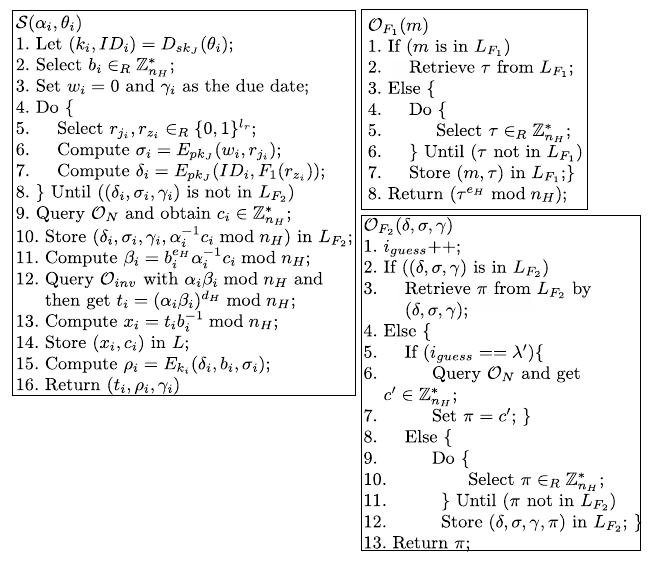
Figure 9. The oracles in the proof of Tamper